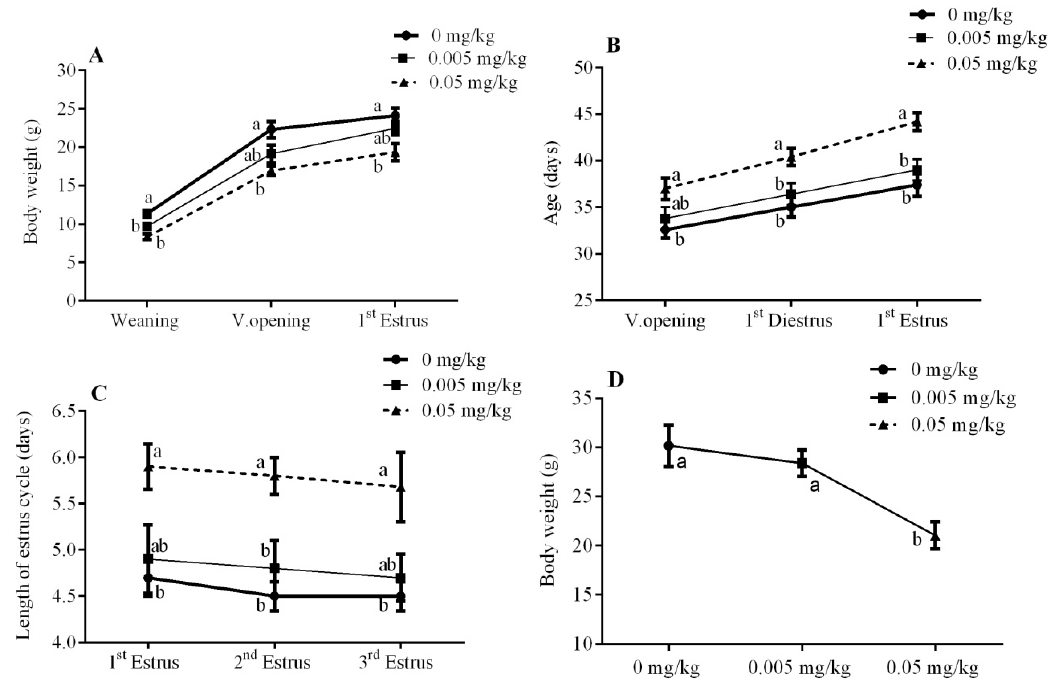
Figure 1. E ff ect of T-2 toxin exposure on: ( A ) body weight (Body weight at Weaning, Vaginal opening, 1st Estrus), ( B ) age in days (Age at Vaginal opening, 1st Diestrus, 1st Estrus), ( C ) length of estrus cycle, ( D ) necropsies body weight after three consecutive estrus cycles, of female mice whose dams were orally administered with T-2 toxin at 0, 0.005, and 0.05 mg / kg from gestational day 14 (GD 14) to lactational day 21 (LD 21). Each value represents the mean ± SEM of the group ( n = 5). Di ff erent letters indicate statistically significant di ff erences, p < 0.05.